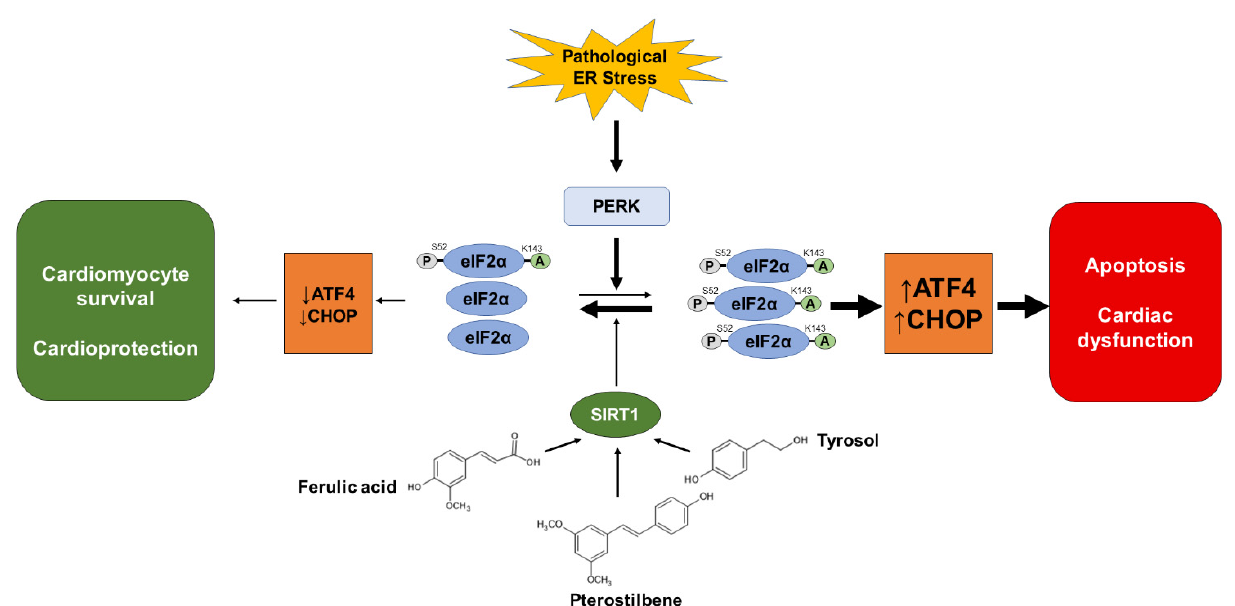
Figure 10. Simplified scheme illustrating the mechanism by which ferulic acid, pterostilbene, and tyrosol protect cardiac cells from adverse effects of ER stress. These phenolic compounds protect cardiac cells from ER stress-induced apoptosis by regulating the PERK pathway of the UPR through SIRT1-mediated deacetylation of the translation initiation factor eIF2 α .